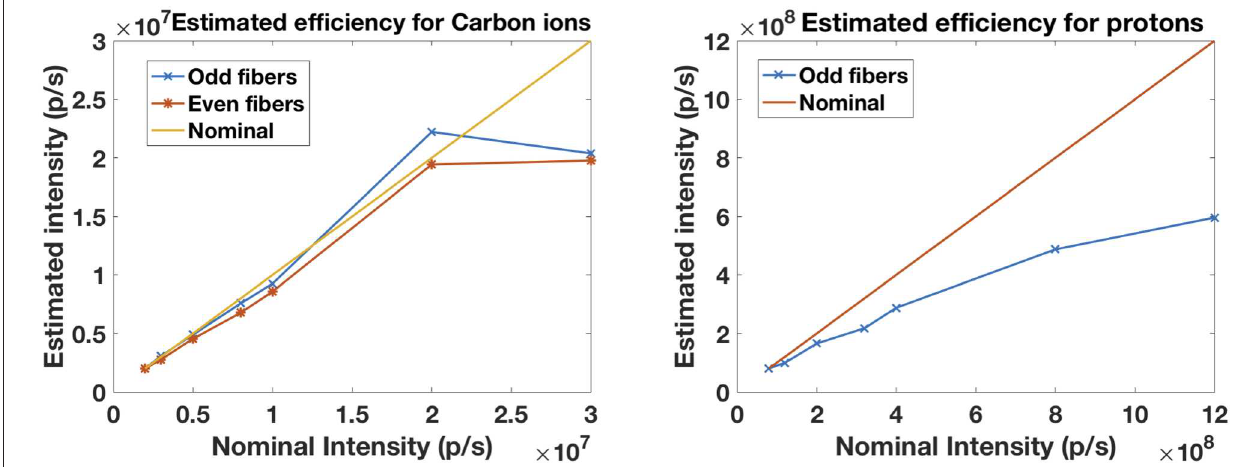
FIGURE 12 | Estimated relative efficiency for the detection of carbon ions (left) and protons (right) by the scintillating fibers for an intensity range of 2 × 10 6 –3 × 10 7 p/s and 8 × 10 7 –1.2 × 10 9 p/s, respectively. Results for odd and even fibers are shown for carbon ions as well as the ideal line.